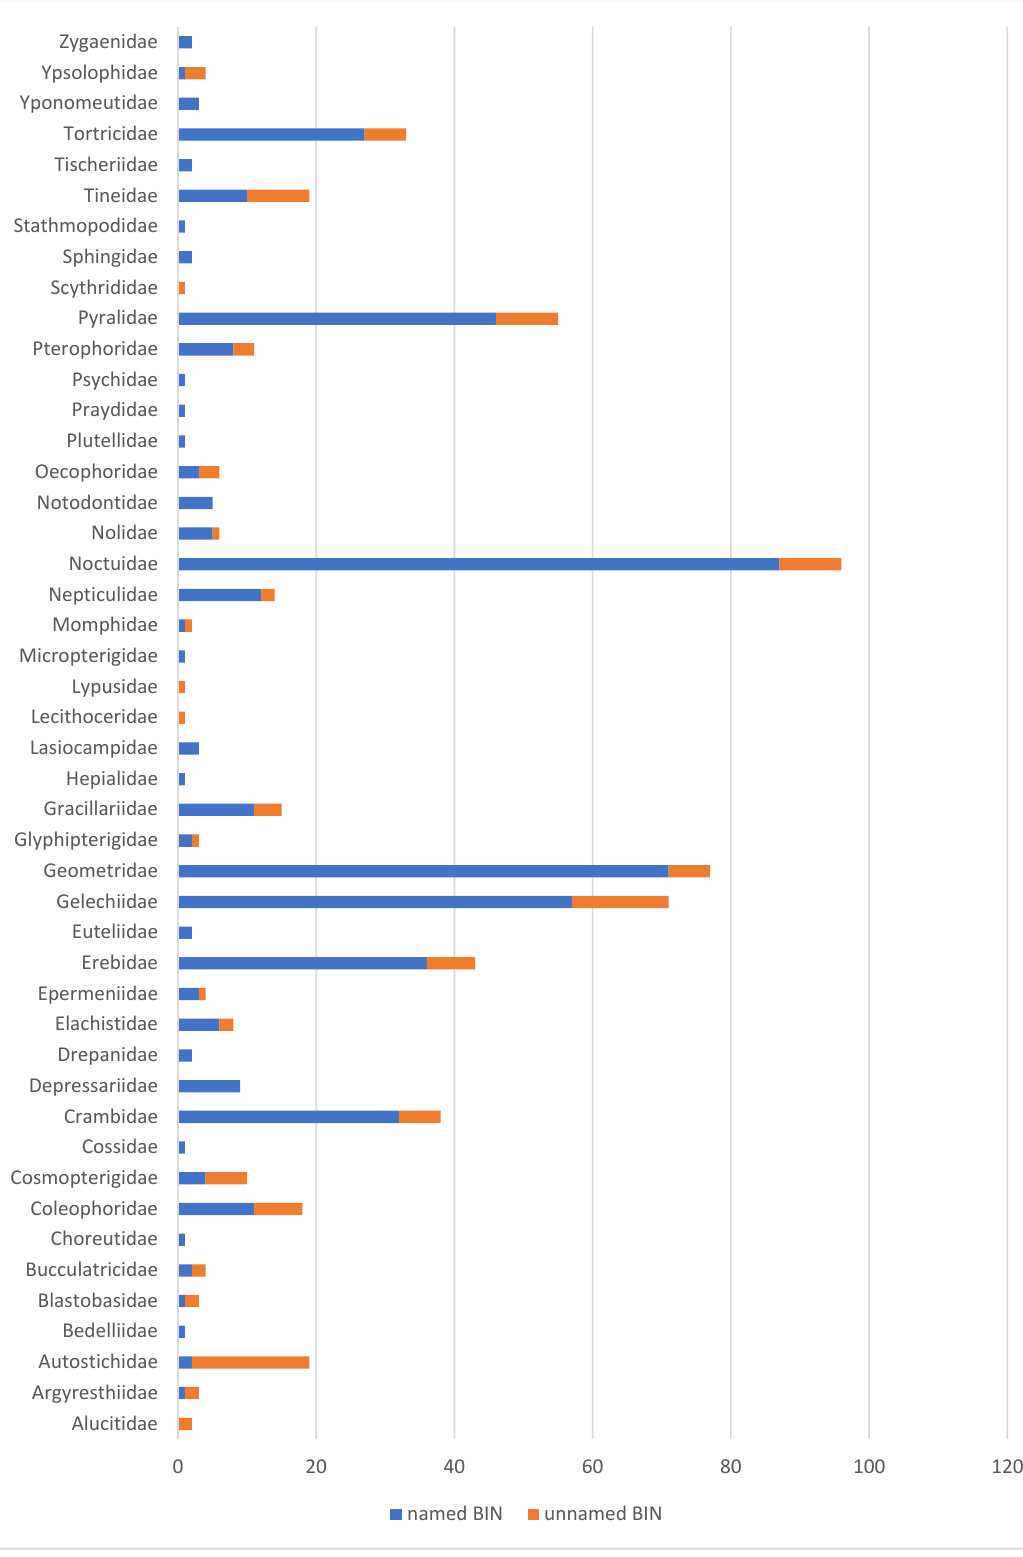
Figure 1. Named and unnamed BINs in a sample of Lepidoptera from Greece.